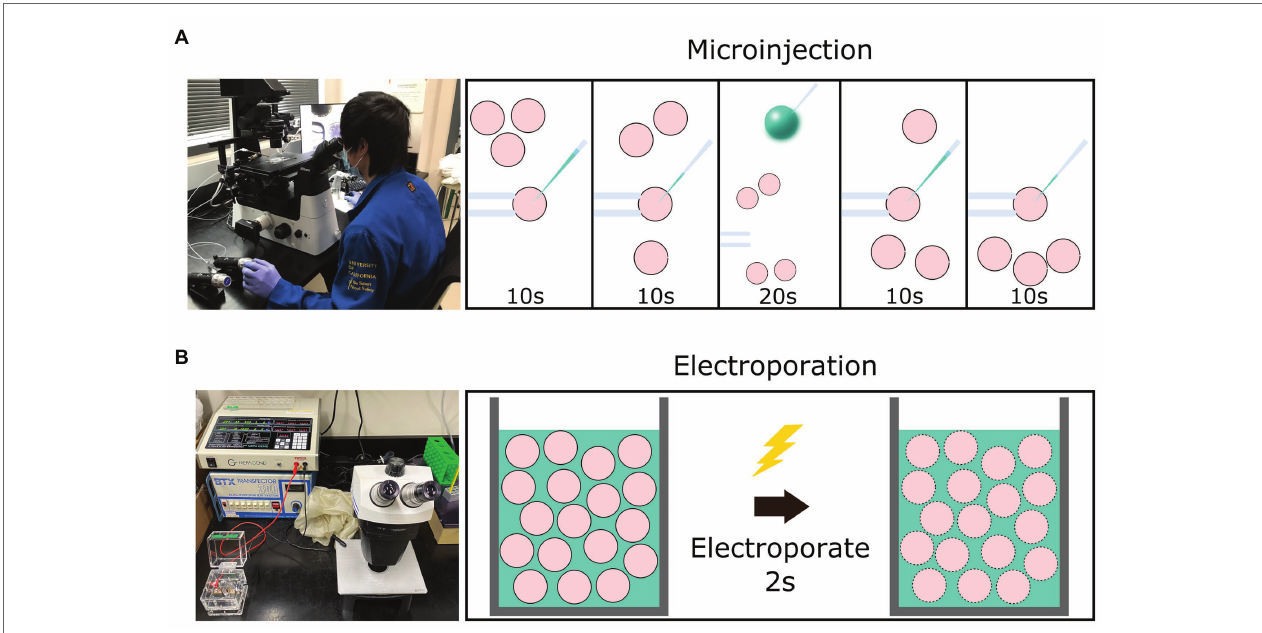
FIGURE 1 | Graphical schematic of a comparison between setup and time necessary for the microinjection vs. electroporation of embryos. (A) The equipment necessary for the microinjection of embryos and the workflow involved to introduce editing reagents (green) into four presumptive zygotes (pink) using a holding needle (left) to stabilize the zygote before introducing the injection needle (right). (B) The equipment necessary for the electroporation of embryos and the workflow involved to introduce editing reagents into 30–100 presumptive zygotes via a